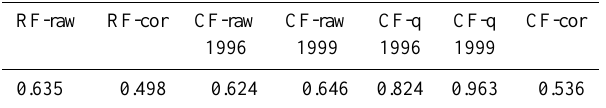
Table 2. Correction factors RF-raw and RF-cor for IHV-raw and IHV-cor from ESK/NGK ratios, CF-raw and CF-q for IHV-raw and IHV-q from the 2ra1h IHV / 1h IHV ratios in 1996 and 1999 and CF-cor from the average correction factor in 1911–1931 for